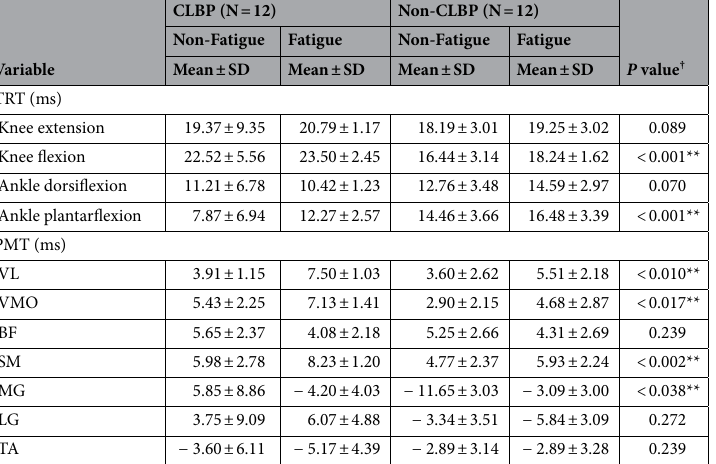
Table 2. Means and standard deviations of total reaction time, premotor time, and electromechanical delay for muscle groups/muscles in CLBP and Non-CLBP groups for the unanticipated trials. TRT total reaction time, PMT pre-motor time, VL vastus lateralis, VMO vastus medialis oblique, BF biceps femoris, SM semitendinosus, MG med gastrocnemius, LG lateral gastrocnemius, TA tibialis anterior, SD standard deviation. ** P value < 0.05 is considered to be statistically significant. † Statistically significant differences between the CLBP and non-CLBP